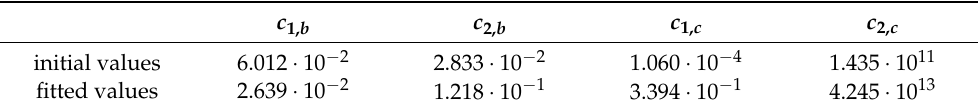
Table 1. Initial and fitted parameters for the C&T PBE submodels, using the two-step parameter estimation routine illustrated in Figure